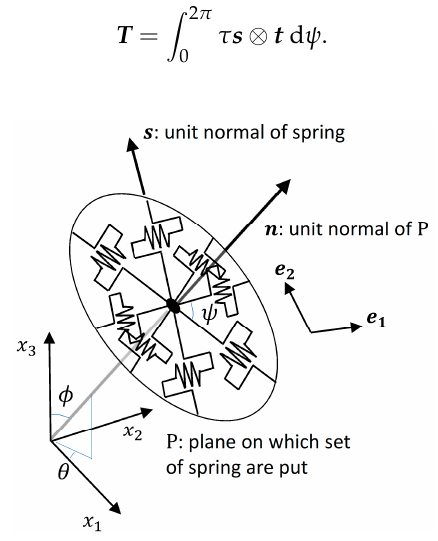
Figure 2. Schematic view of the original mode.